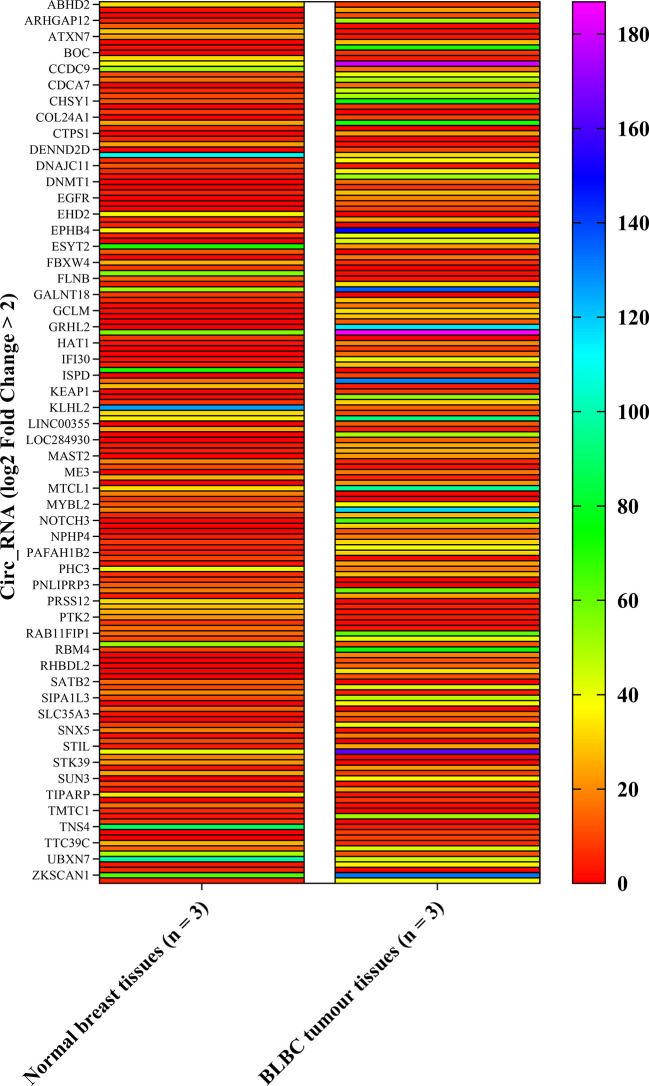
Heat map of circ_RNA array. The left row contains circ_RNAs. The column contains normal breast tissues and BLBC tumor tissues expression value. circ_NOTCH3, which the most upregulation log2FC times, was selected for further analysis. (log2FC>2). BLBC, basal-like breast carcinoma; FC, fold change; circ, circular.